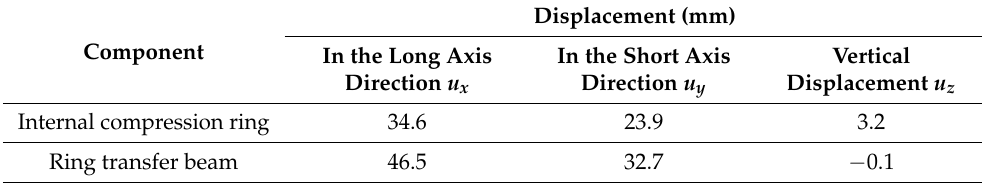
Figure 6. Structural stress in zero-stress state. Table 3. The structural displacements in the zero-stress state.